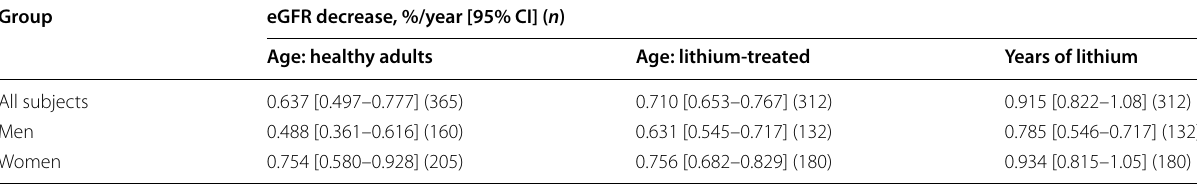
Lithium-treated subjects are from the present study. Data for healthy adults are adapted from Rule et al. (2004) for clearance of iothalamate. Rates of GFR decrease as %/year are computed as [initial eGFR observed eGFR]/[initial eGFR] 100 with 95% confidence intervals and number ( n ) of subjects (eGFR is in units of mL/ − × min/1.73 m 2